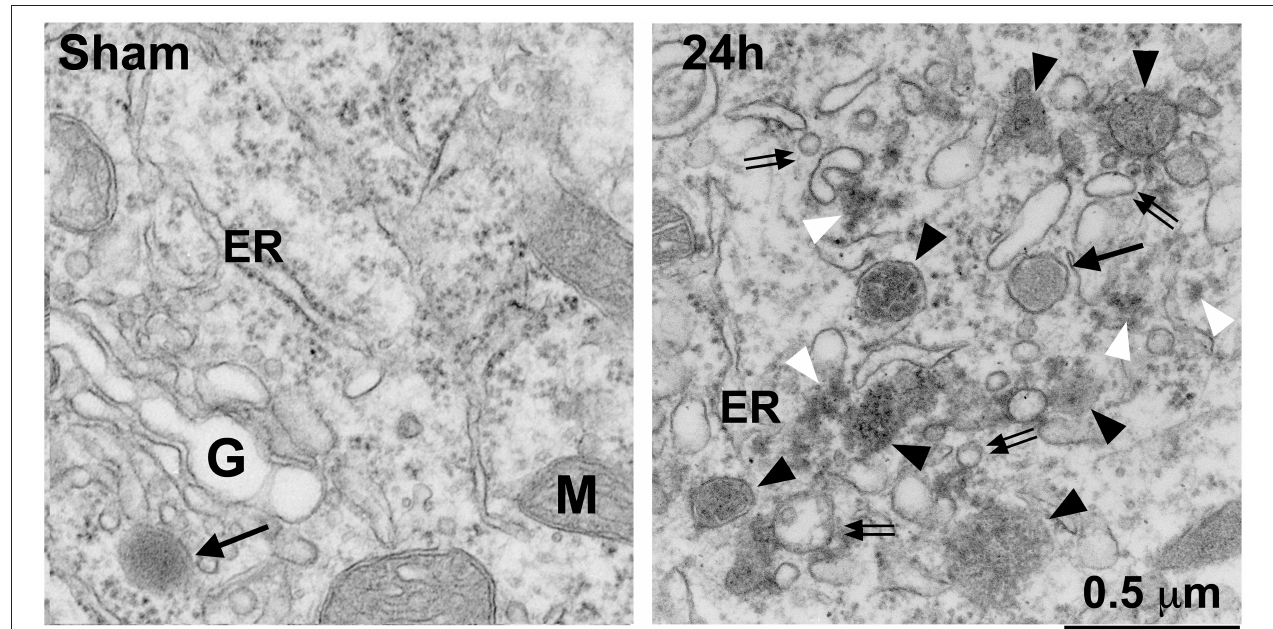
FIGURE 2 | Electron microscopy of Golgi fragmentation and buildup of endolysosomal structures and protein aggregates after stroke. The ultrathin neocortical sections were obtained from a sham-operated control rat and a rat subjected to 2h of MCAO followed by 24h of reperfusion. Sham: A sham neuron showing normal rough endoplasmic reticulum (ER), mitochondria (M), Golgi apparatus (G), and lysosome (arrow). 24 h : A 24h reperfused neuron showing complete fragmentation of the Golgi apparatus into vesicles or vacuoles (double arrows) and buildup of various sized late endosomes (black arrowheads) and protein aggregates (white arrowheads). Arrow points to a terminal lysosome. Scale bar = 0.5 µ